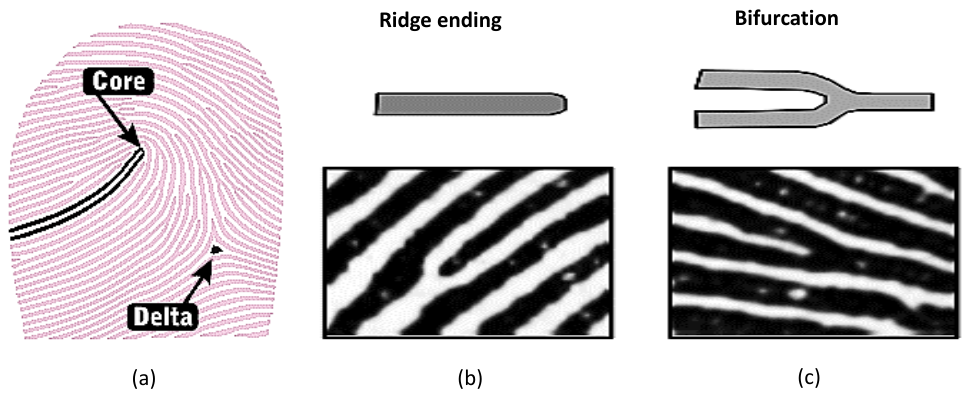
Figure 1. Typical Minutiae structures: ( a ) core and delta singularities; ( b ) ridge ending; and ( c ) ridge